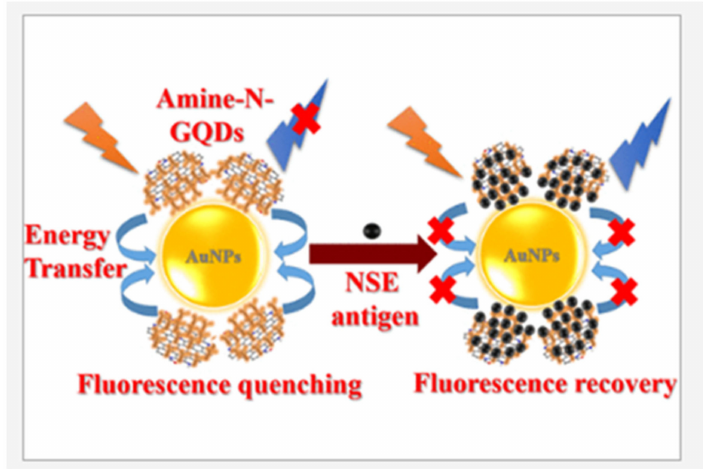
Figure 9. Fluorescent biosensor working mechanism for the detection of cancer biomarkers (reprinted from Ref. no. [101], copyright 2020, American Chemical Society).